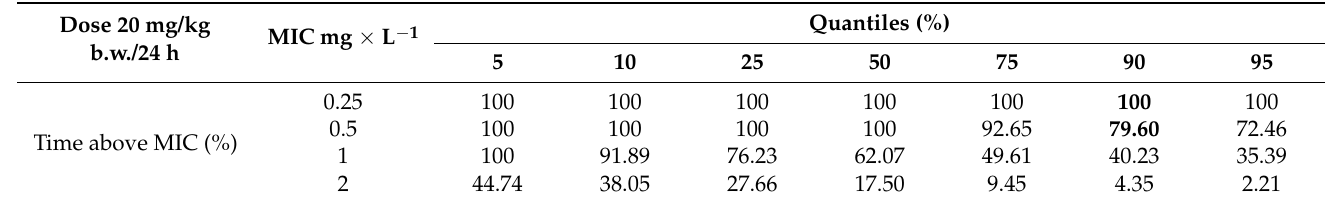
Table 3. Probability of target attainment (%) for % f T > MIC ≥ 80 and 100 for possible MICs of doxycycline in the range from 0.25 to 2 mg × L − 1 and for a dosing regimen of 20 mg/kg b.w./24